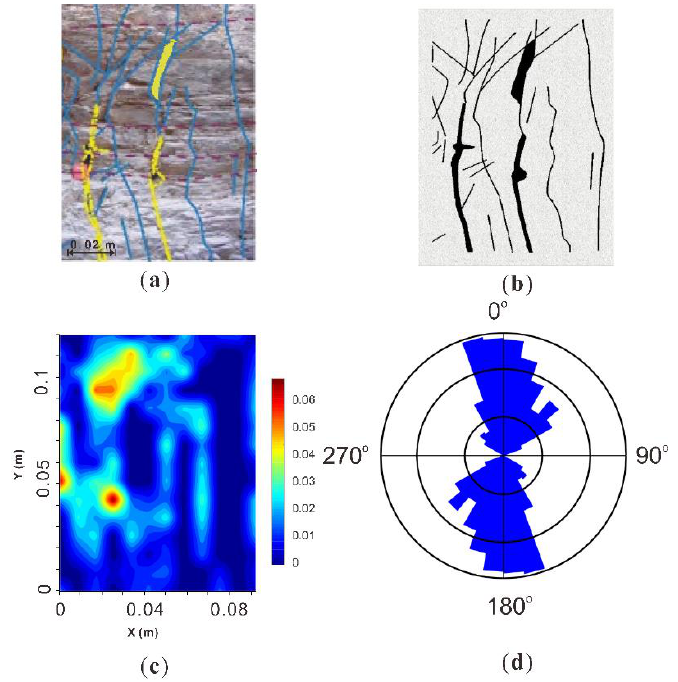
Figure 10. 2D real-fracture model and its geometric characteristics: ( a ) rock outcrop of Ordovician carbonates in Tarim Basin, northwest China; ( b ) the model can be composed of the background media and extracted fractures; ( c ) the model’s fracture density distributions where the red and yellow areas in the maps indicate more fractures than others; ( d ) the equal-area rose diagrams of fracture length, which provide dip